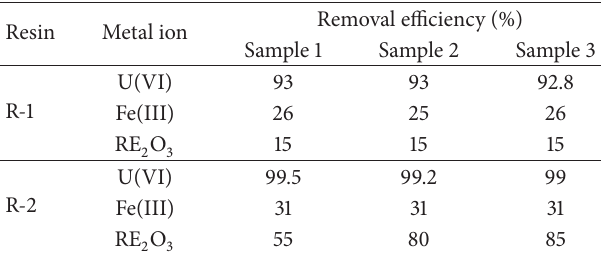
Table 6: Results of treatment of the granite samples with the studied resins. Resin Metal